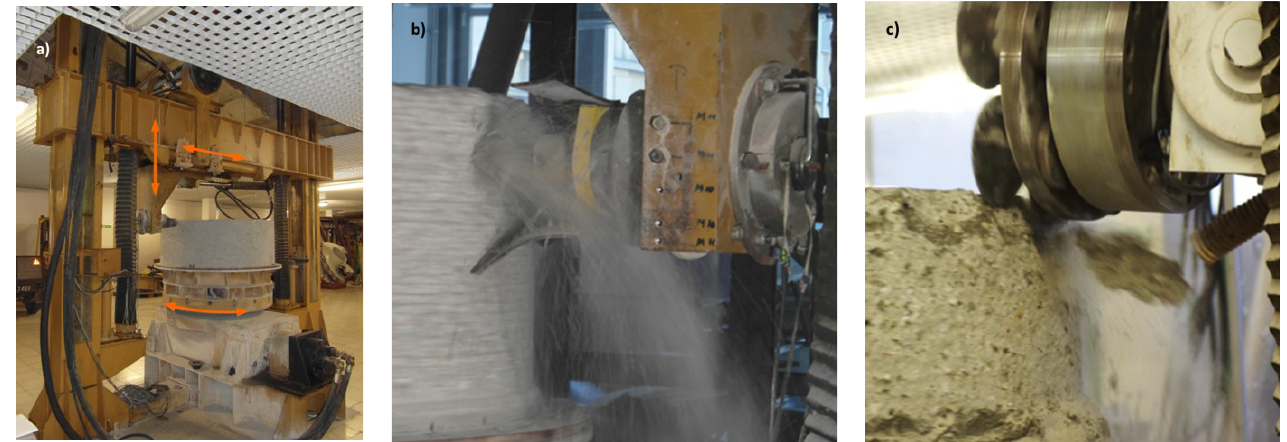
Figure 15. Stand for testing conical picks and discs: ( a ). general view of the stand, ( b ). the testing of a conical pick, and ( c ). the testing of a driven plate with discs [39].